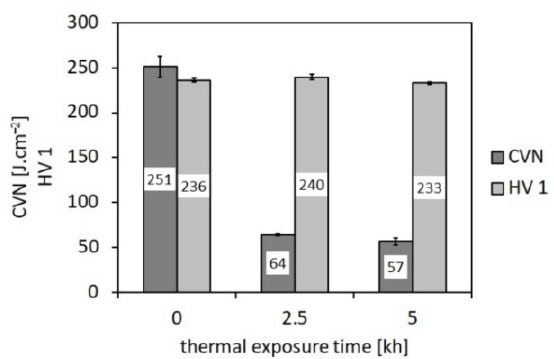
Figure 8. Effect of duration of thermal ageing of investigated P92 steel at 600 °C on impact toughness and hardness.